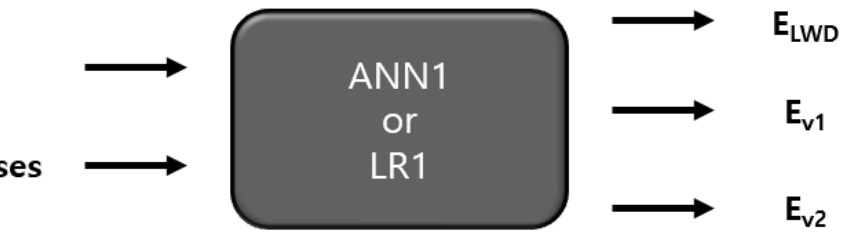
Figure 11. Features and labels for ANN1 and LR1 models.